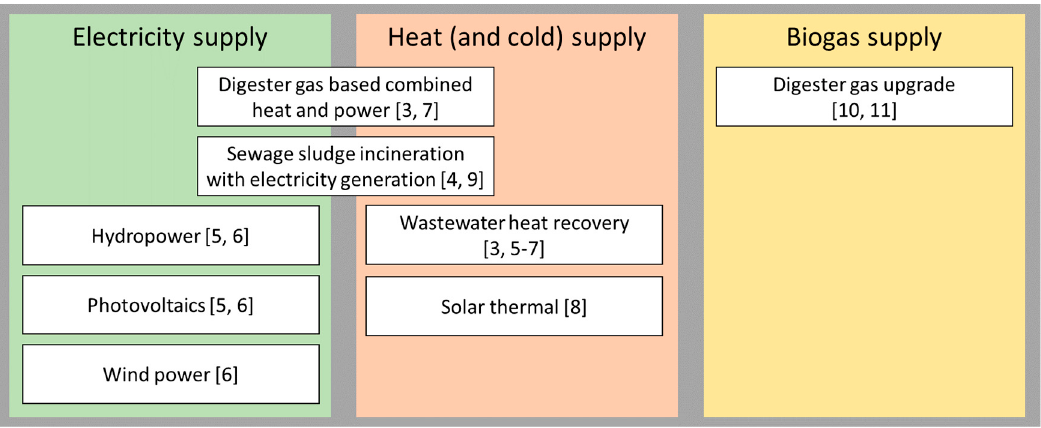
Figure 1. Wastewater-based supply of electricity, thermal energy, and biogas [3–11] .